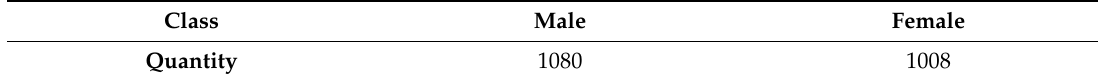
Table 2. Genders in the CIA database.